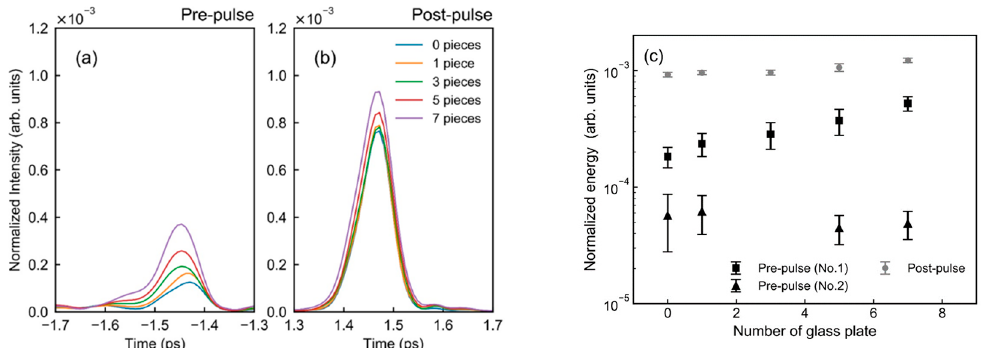
Figure 3. ( a , b ) Temporal contrast for the pre- and post-pulses and ( c ) normalized energy of pre- and post-pulses with the addition of a glass sheet at a laser energy of 14 mJ. The values in ( a , b ) indicate the number of glass plates. The experimental conditions are listed as Nos. 1 and 2 in Table 1.